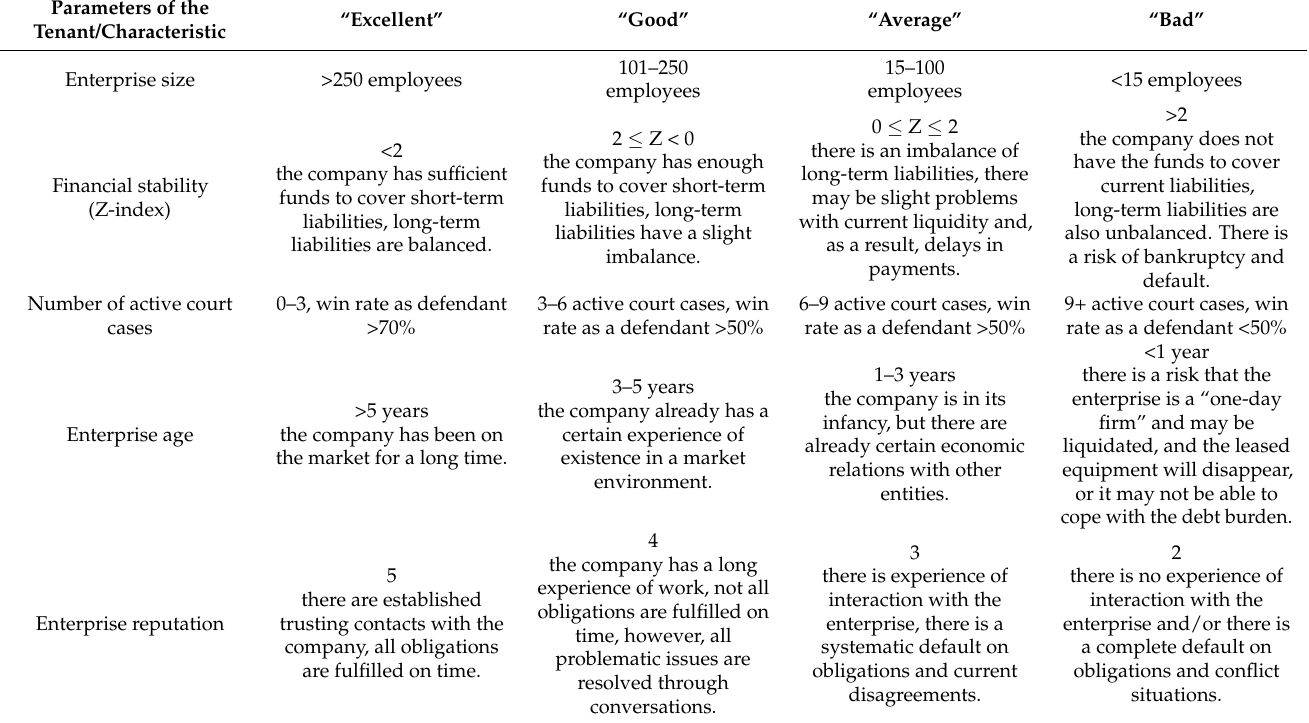
Table 2. Parameters of the tenant’s enterprise and their linguistic